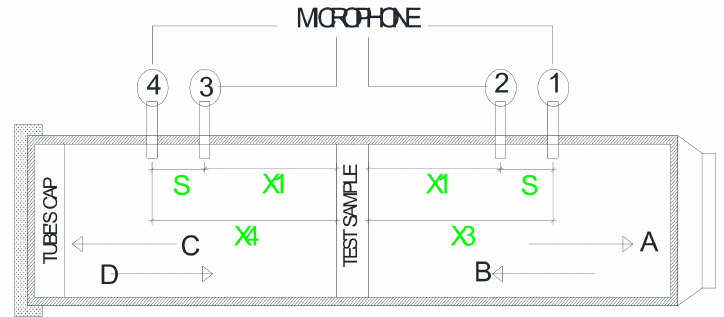
Figure 2. The impedance tube section for the sound transmission loss test with four microphones